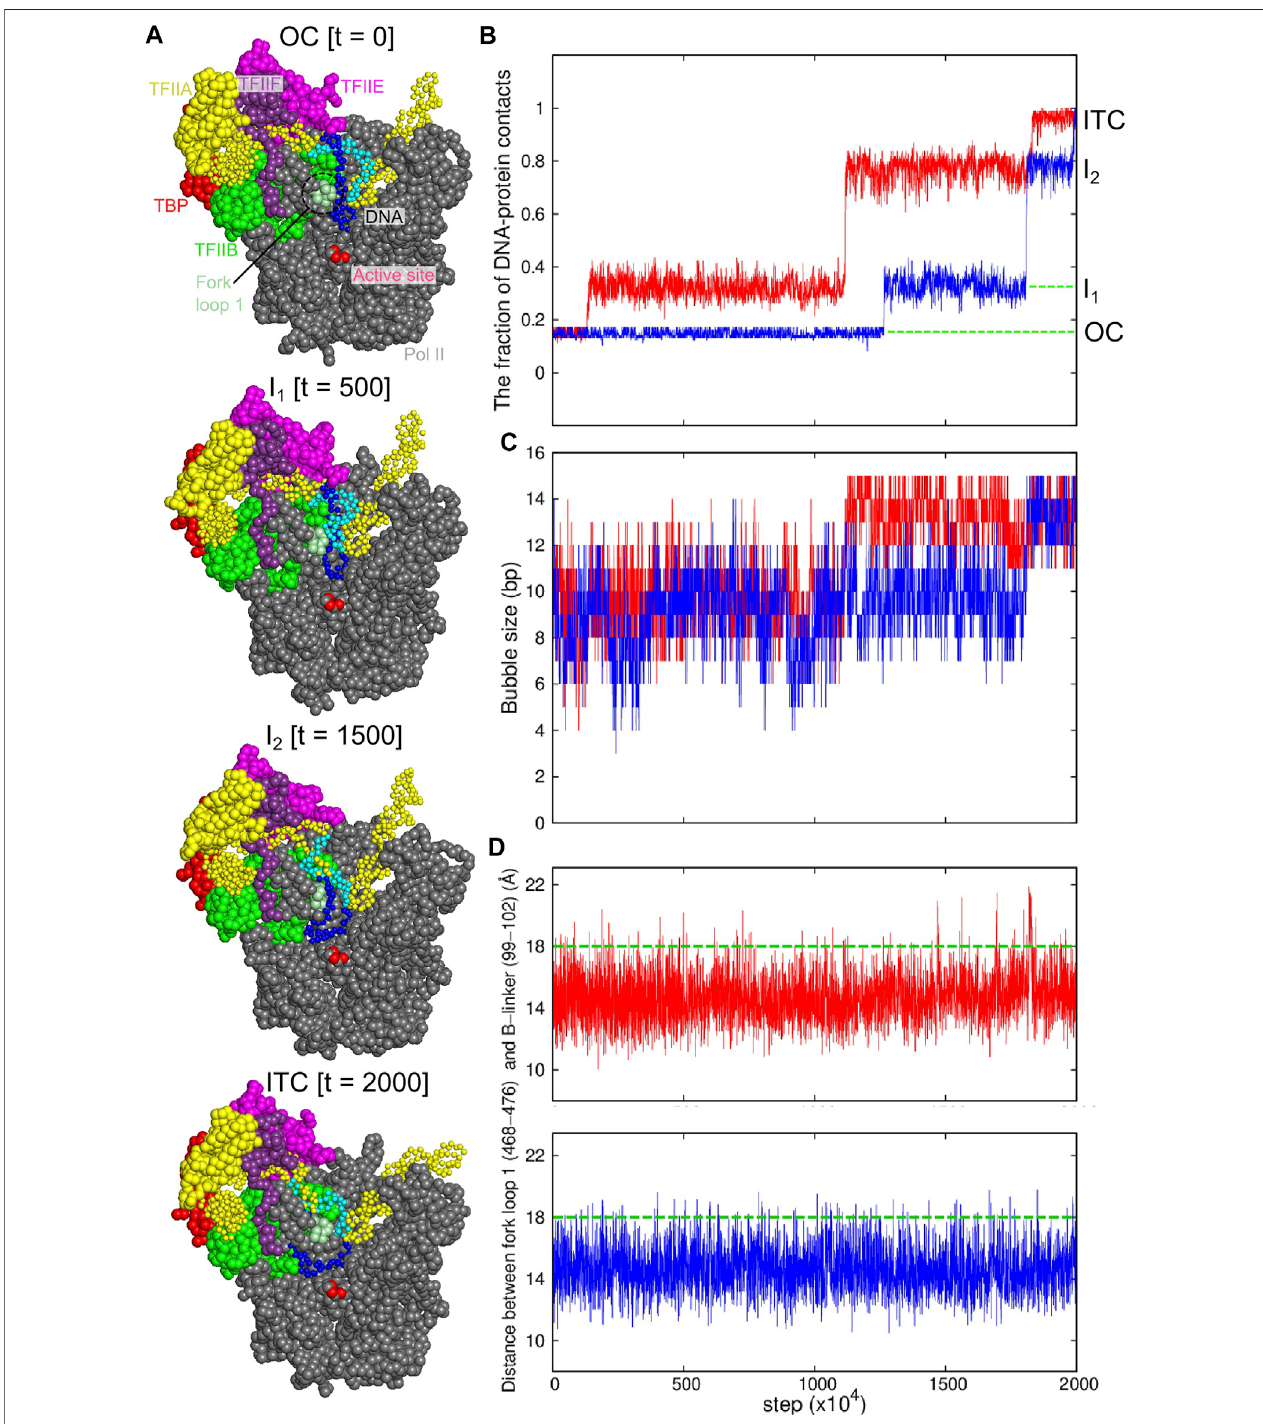
FIGURE4| Coarse-grained MDsimulationfor thetransition from theOCtoITC states. Resultsoftworepresentativetrajectories areshown in red and bluecurves. (A) Snapshots from the red trajectory at 0 MD step (top, the OC state), at 500 × 10 4 MD steps (I 1 state), at 1500 × 10 4 MD steps (the I 2 state), and 2000 × 10 4 MD steps (bottom,theITC state). (B) The time courseofthefractions ofprotein-DNAcontactsspeci fi ctoITC. (C) Thetimecourse oftheDNAbubble size. (D) The time coursesof thedistancebetweenthecentersofmassoftheforkloop1ofthePolIIRpb2(468 – 476residues)andtheB-linkerinTFIIB(99 – 102residues).Greendashedlines,a characteristic distance for the template DNA to pass through the fork loop